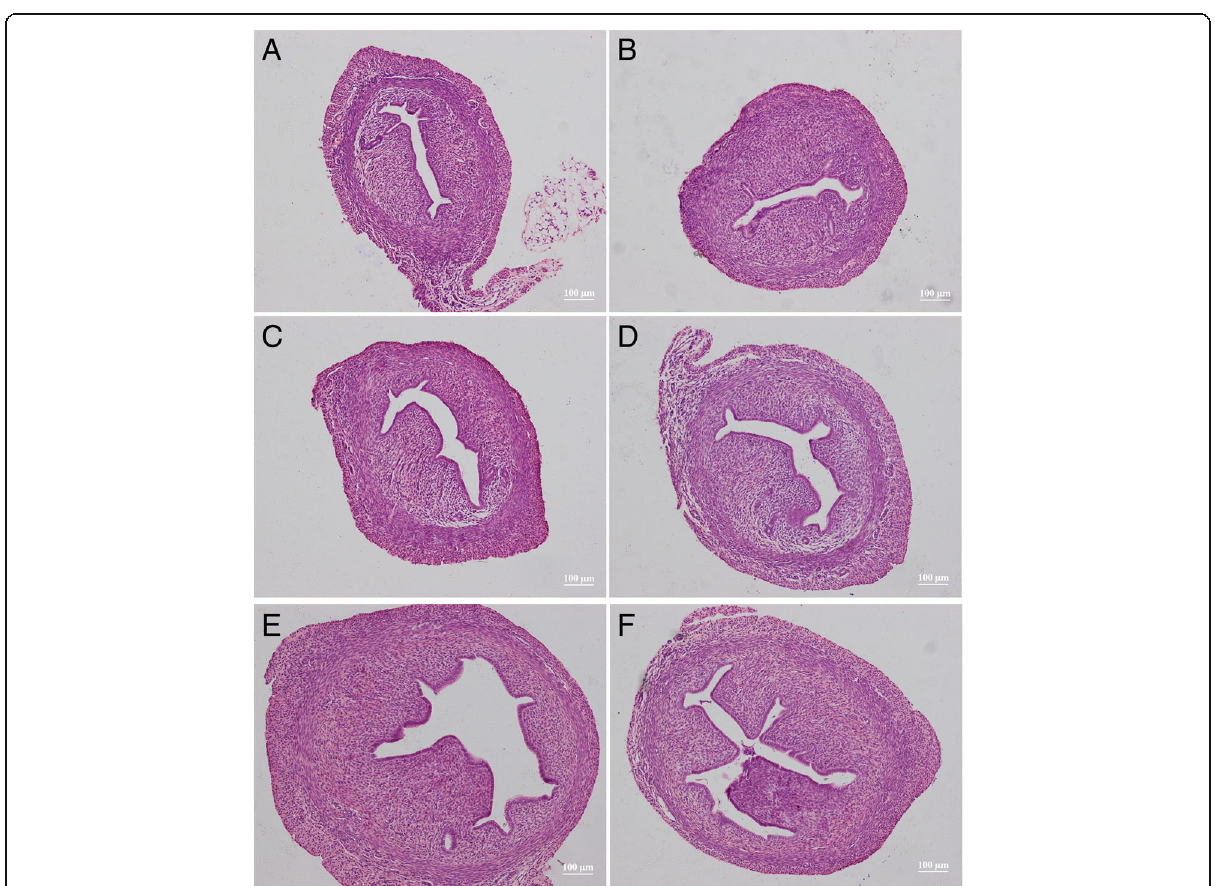
Fig. 4 Hematoxylin and eosin stained images of the uterus from solvent control ( a ) and rats receiving BPA dosages of 15 ( b ), 30 ( c ), 60 ( d ), 120 ( e ), and 240 mg/kg body weight ( f